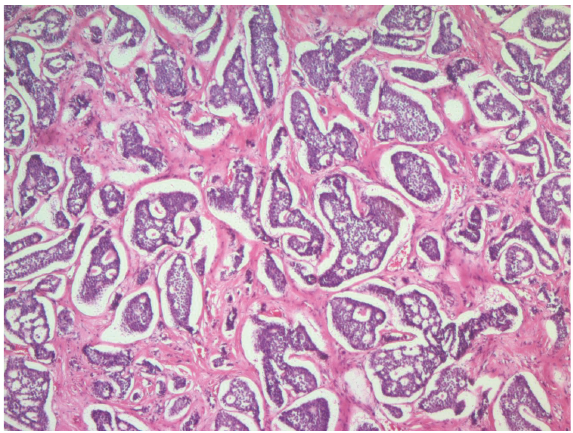
Figure 1: Nests and cribriform structures of variable size and shape, separated by moderateamount of fibrotic dense stroma (H&E; 50x).